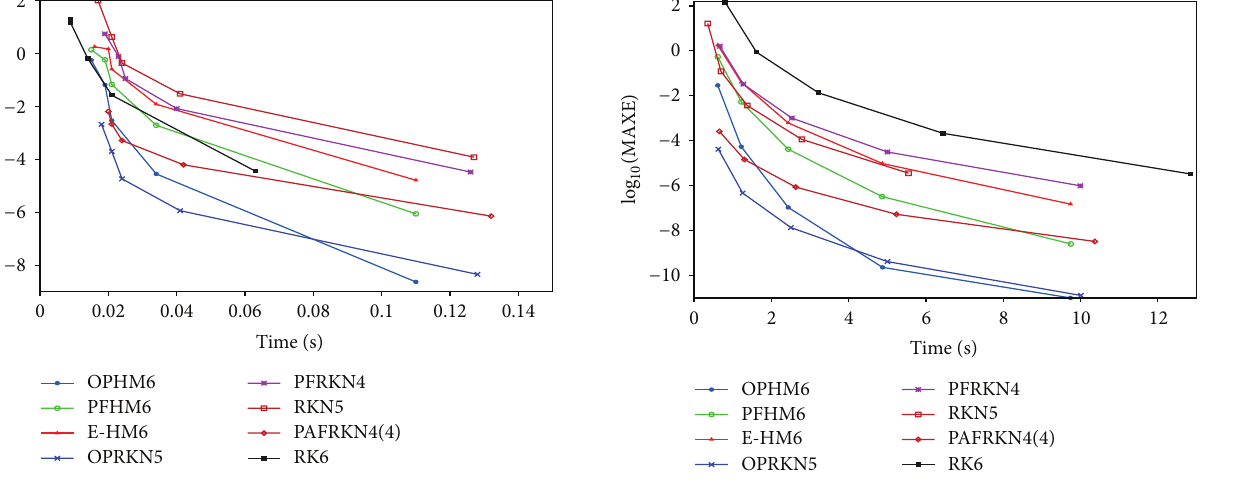
Figure 10: The efficiency curves of the optimized order six method and their comparisons for Problem 4 with 𝑡 0.125𝑖 , 𝑖 = 1,...,5 .